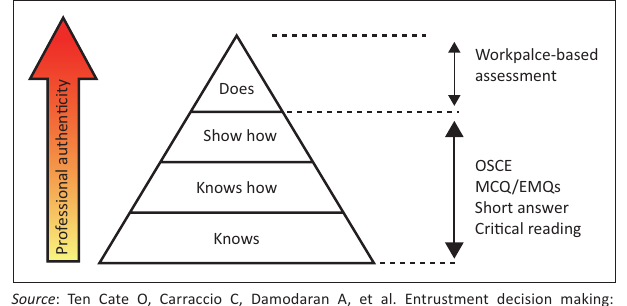
FIGURE 2: Design of the national licencing examination and Miller’s